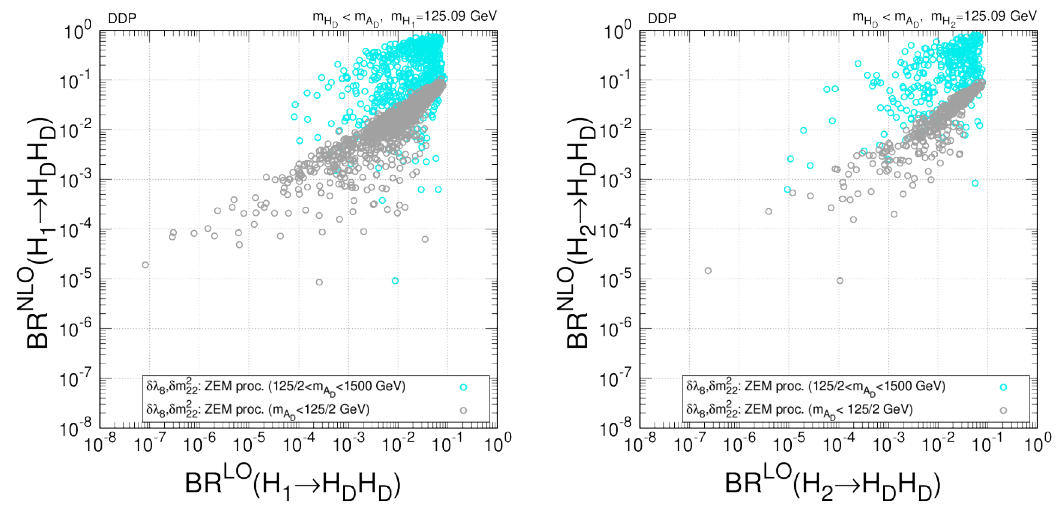
Figure 5 . Correlation between the branching ratios at NLO and at LO in scenario 1 (left) and scenario 2 (right). All points have been obtained in the ZEM process-dependent scheme. The grey points correspond to the previous sample where m correspond to a range that is only allowed in the ZEM scheme, 125 / 2 GeV < m